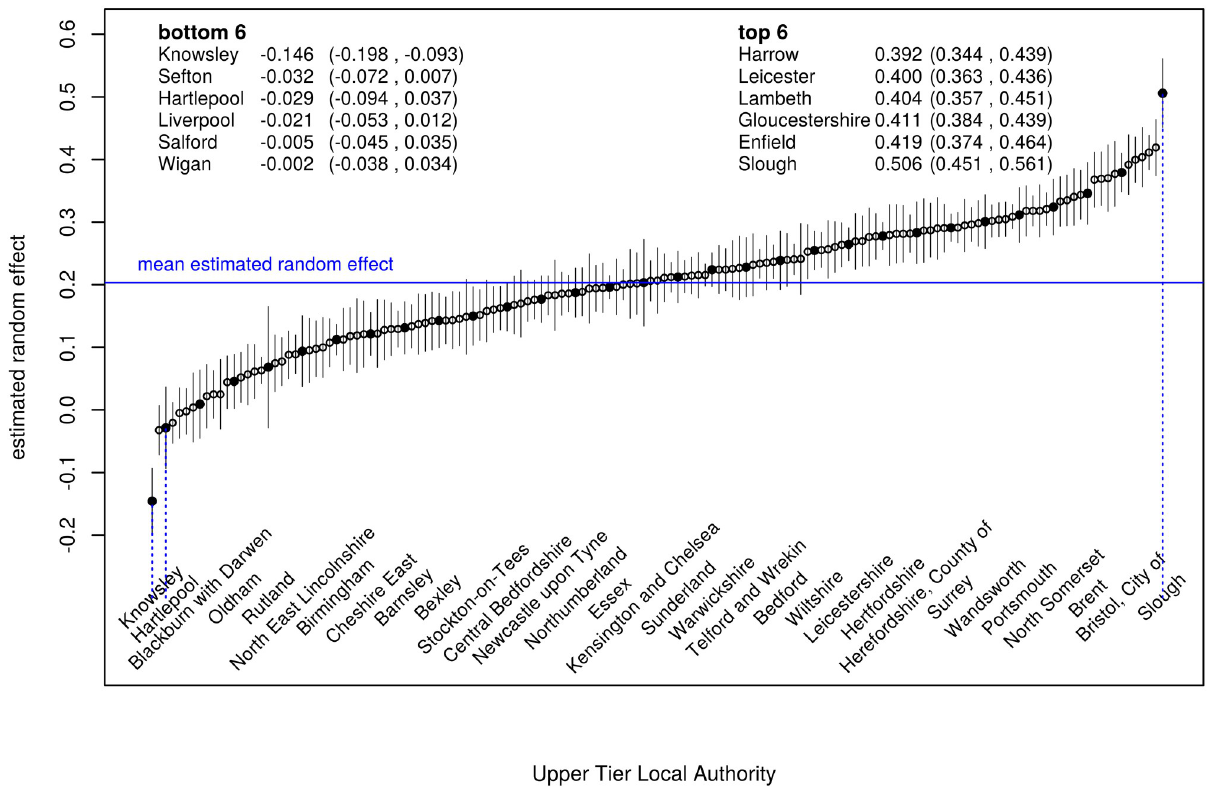
Fig 3. “Caterpillar plot” for model D for the Third Injection. Each estimated random effect is displayed with a point whose y-value is c segment showing its 95% credible interval. The points are ordered along the x-axis by increasing value of c i . Points marked • also show the Upper Tier Local Authority name below. The blue line shows the mean value of c